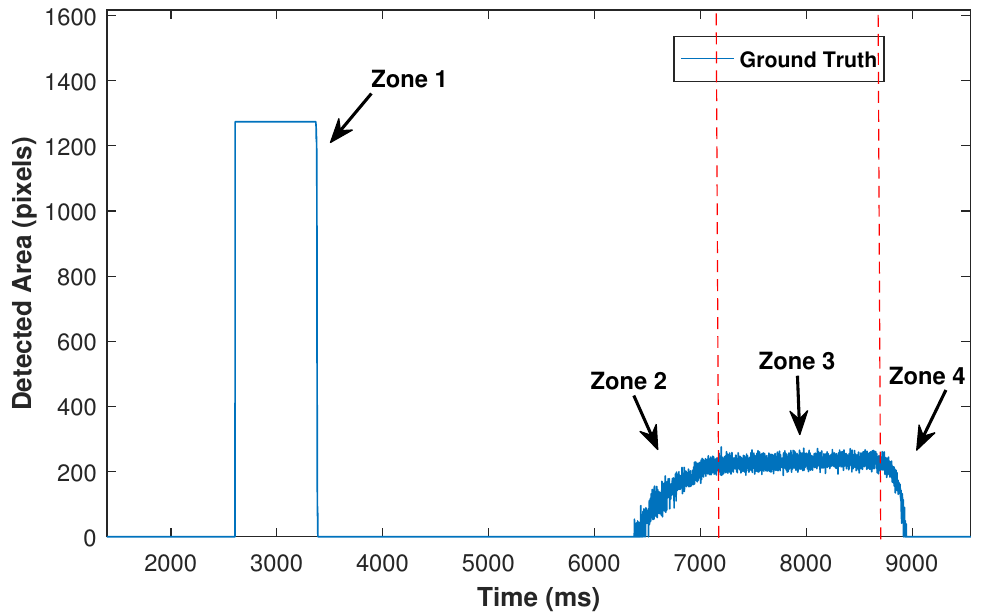
Figure 11. Detected area by high speed camera. (1) synchronisation phase; (2) increasing force to grasp the object; (3) holding the object; (4) releasing